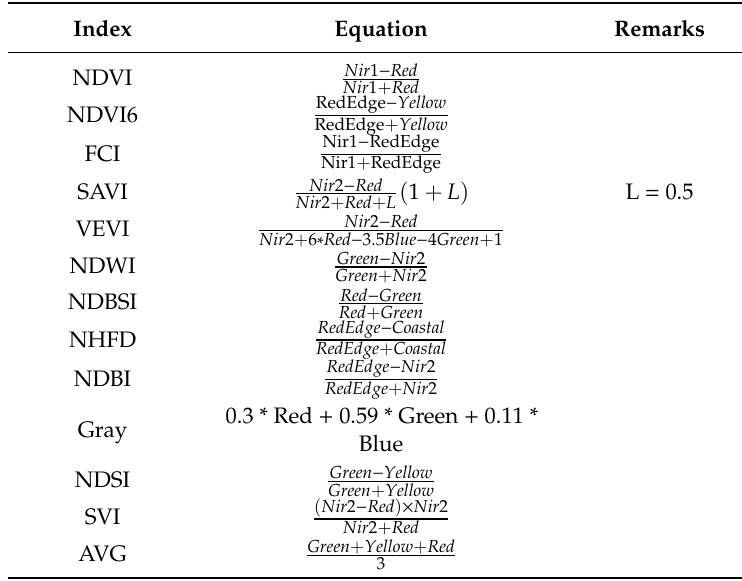
Table 1. Some commonly used spectral